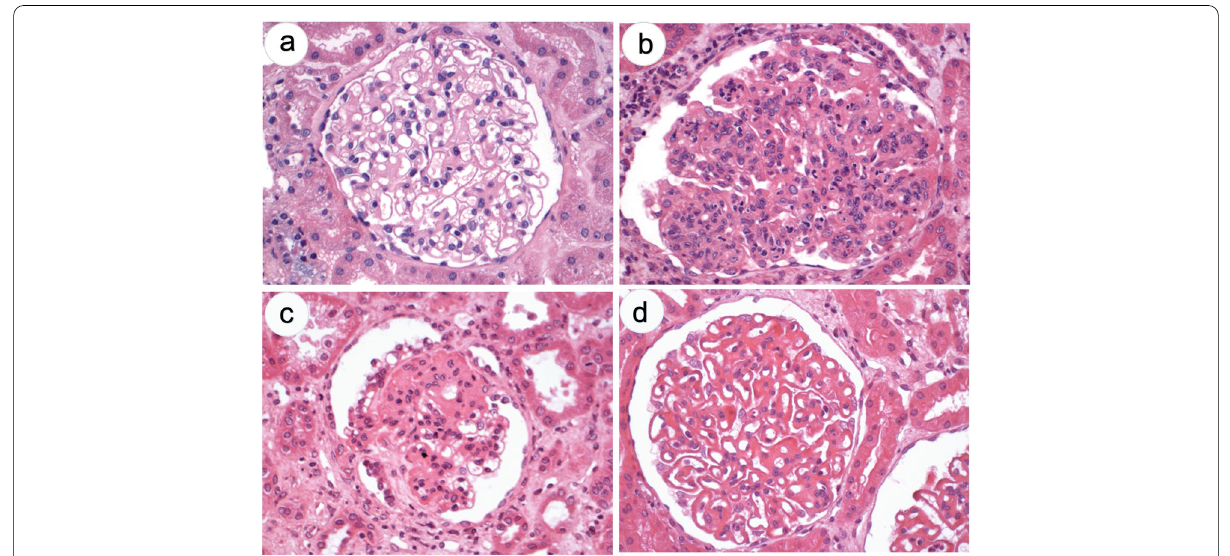
Fig. 2 Normal glomerulus ( a ) and lesions defined as the subject of study by the PathoSpotter project ( b ‑ d ): b – glomerular hypercellularity, c – glomerular segmental sclerosis, d – membranous glomerulopathy. Hematoxylin–eosin stain,